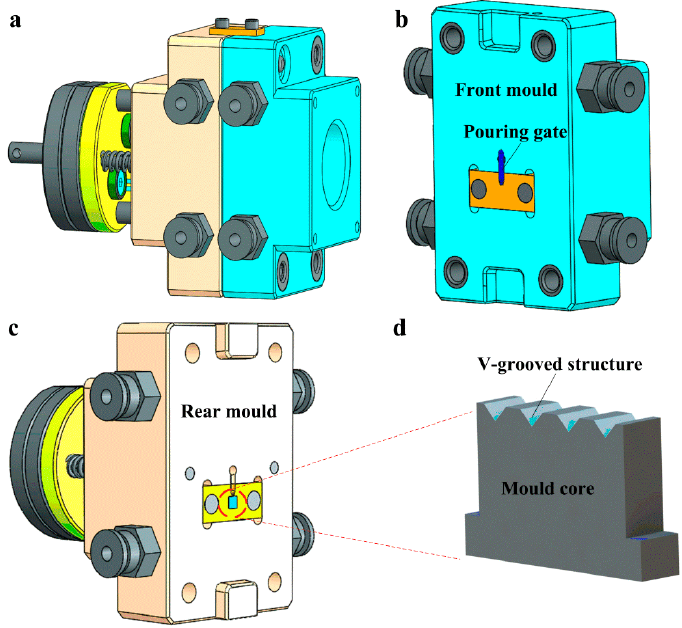
Figure 3. The design sketches of mold frame and mold core: (a) the whole mold frame; (b) the front mold; (c) the rear mold; (d) the mold core.